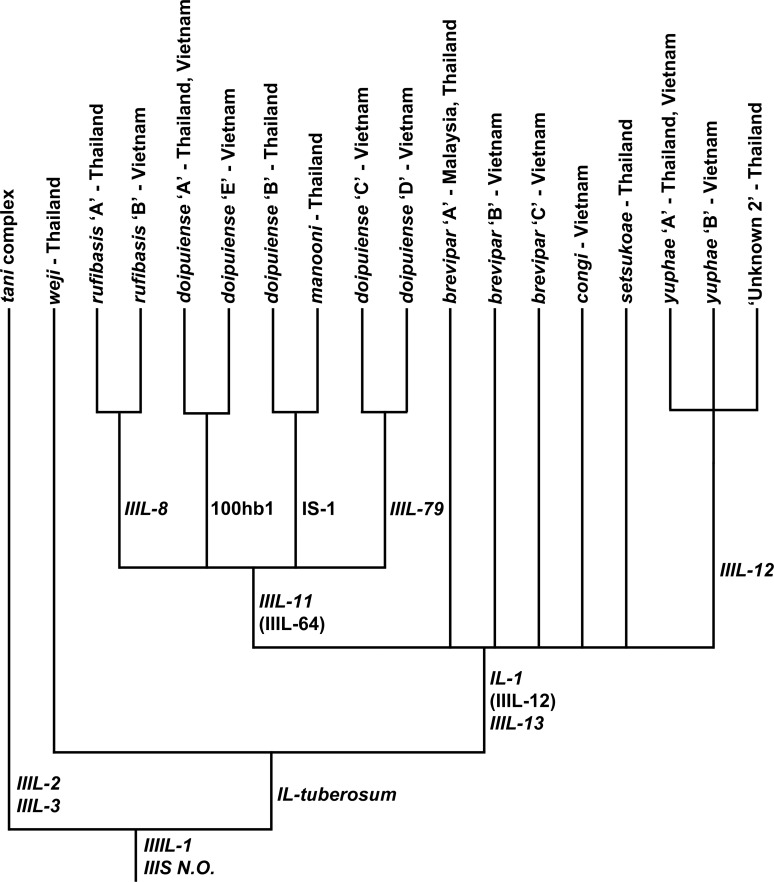
Cytophylogeny of the Southeast Asian Simulium tuberosum subgroup.Rearrangements are used only if they were determined to be derived relative to the outgroups (Simulium erythrocephalum and Simulium vittatum; not shown). Italicized rearrangements are fixed; polymorphisms are in parentheses.